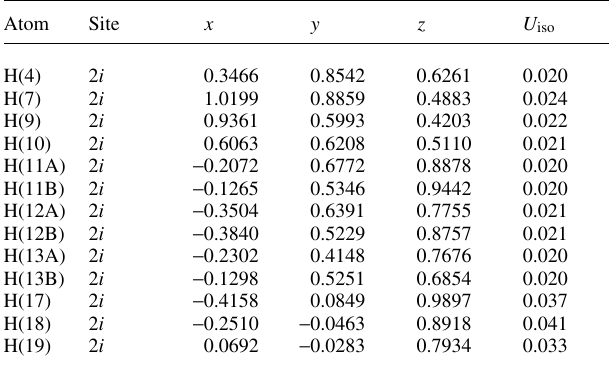
Table 2. Atomic coordinates and displacement parameters (in Å 2 ) .